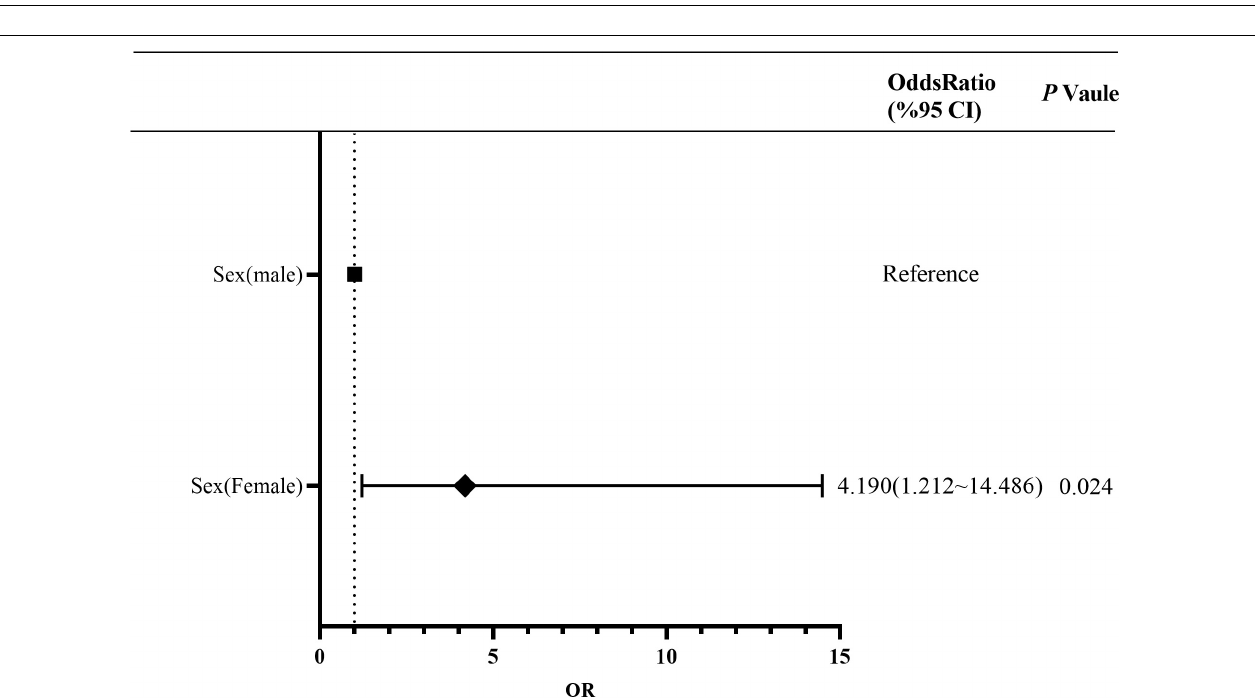
FIGURE 4 | Multivariate risk factor analysis of PI population. PI, polymicrobial infection.